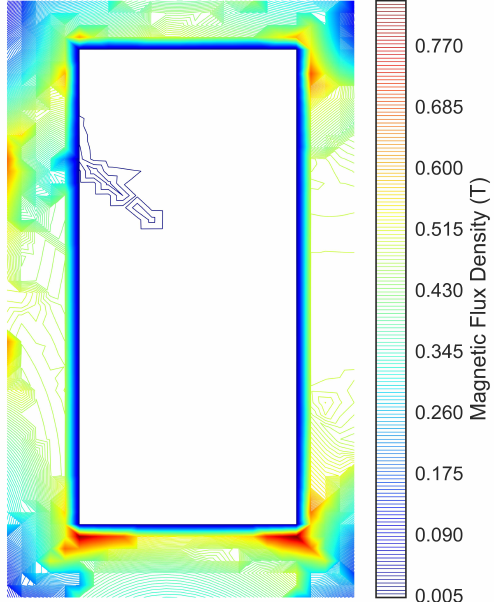
Figure 11. The simulated magnetic contour field of the single phase